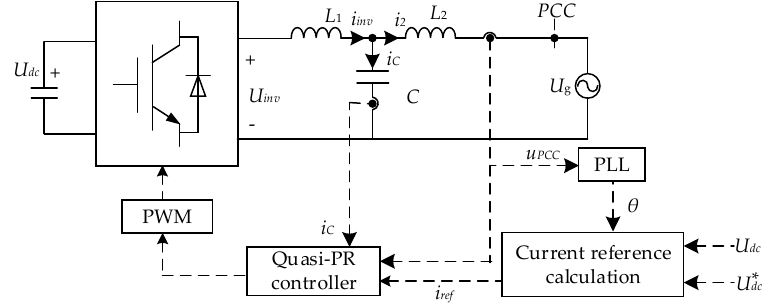
Figure 1. System structure of single − phase grid − connected inverter with LCL filter.